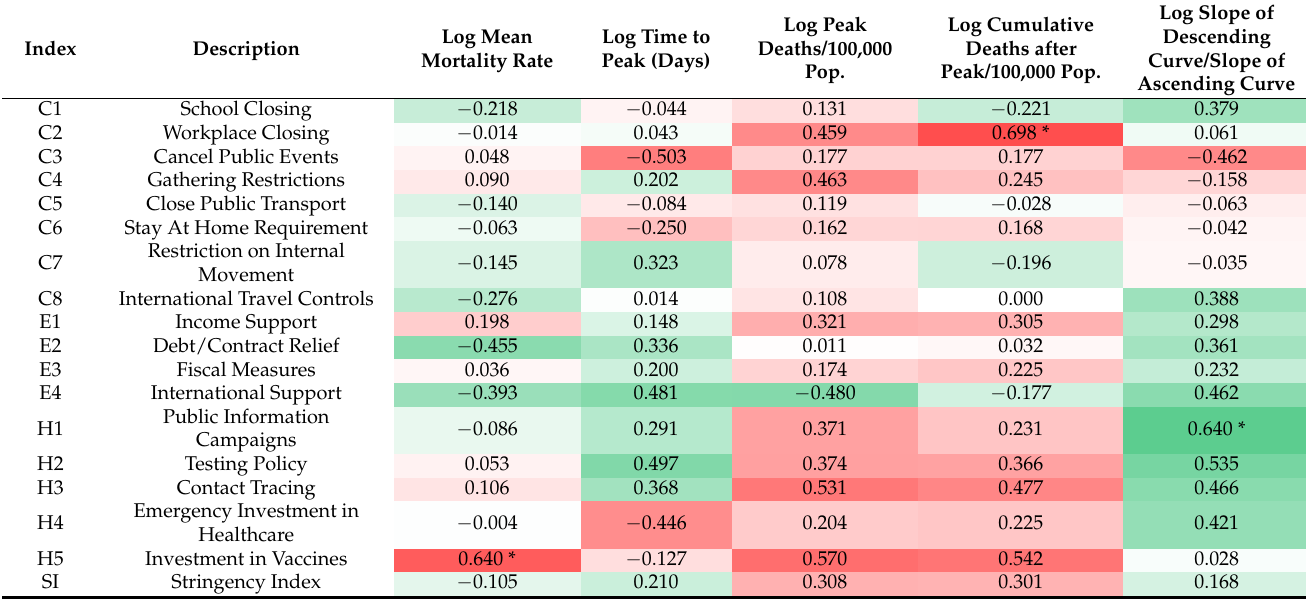
Table 4. Spearman rank-order correlation coefficient of policy indicators and the Stringency Index against five different measures of pandemic severity in low-income countries based on median GDP per capita